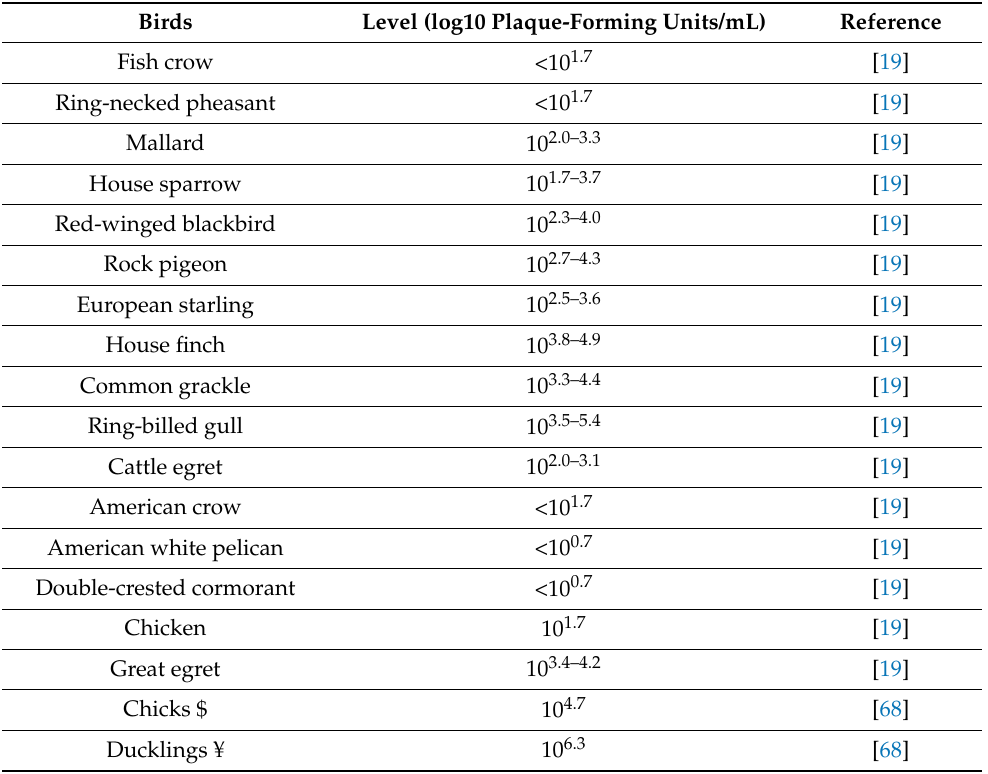
Table 1. Summary of viral titers of birds experimentally inoculated with Japanese encephalitis virus.